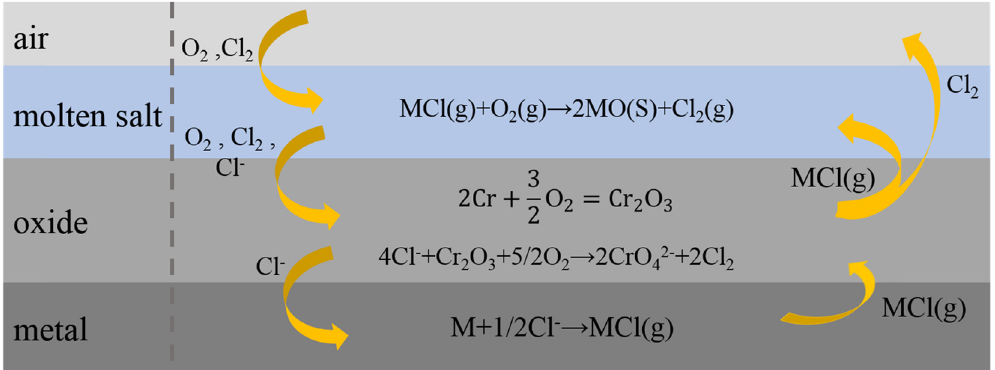
Figure 12: Schematic diagram of activated